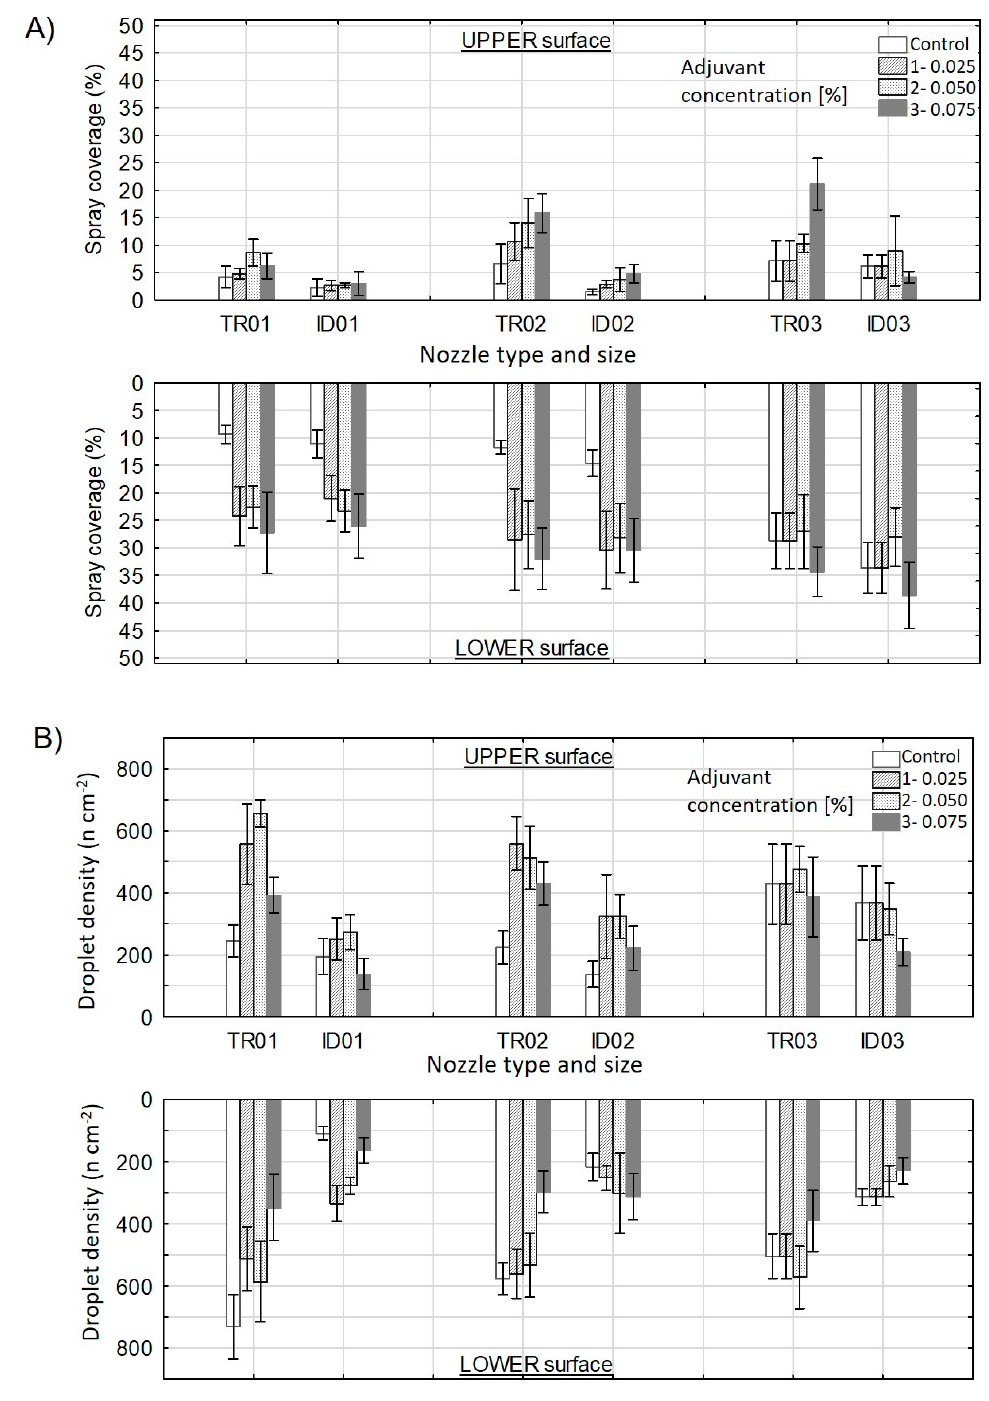
Figure 4. Effects of Greemax adjuvant concentration and nozzle type and size (TR—fine spray hollow cone nozzles; ID coarse spray flat fan air-inclusion nozzles); nozzle sizes 01, 02, 03 acc. to ISO 10625:2018 on: ( A ) spray coverage on the upper and lower leaf surface (%) (mean); ( B ) droplet density on the upper and lower leaf surface (n cm − 2 ) (mean).